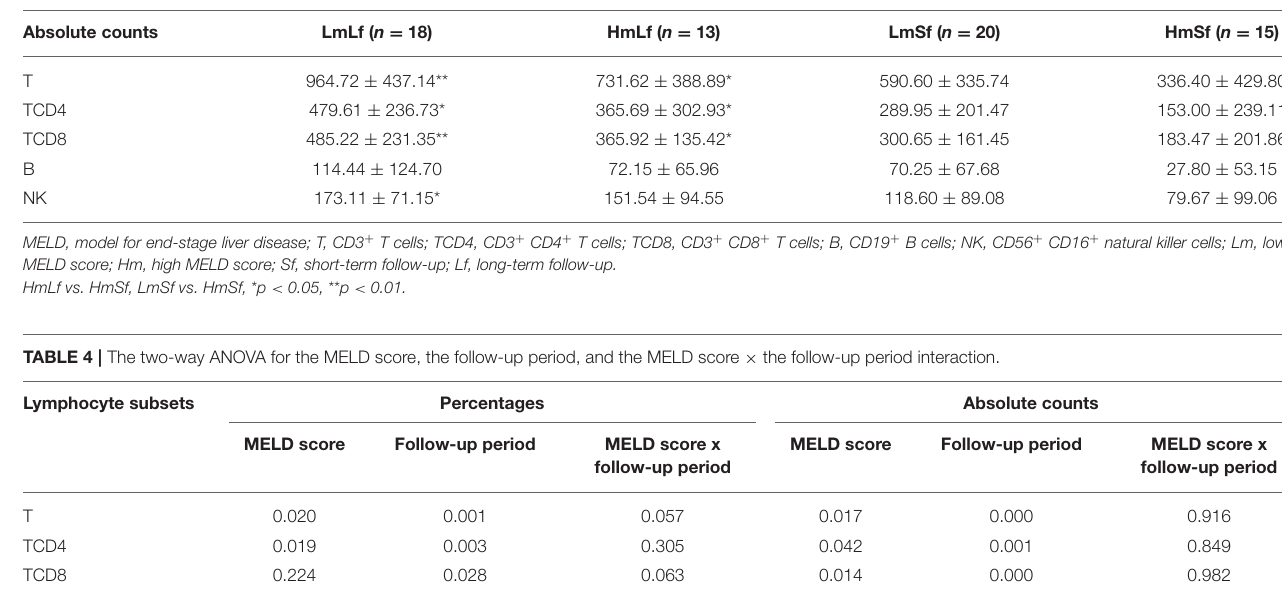
TABLE 3 | Effects of the MELD score and the follow-up period on the absolute counts of lymphocyte subpopulations following liver transplantation. Absolute counts